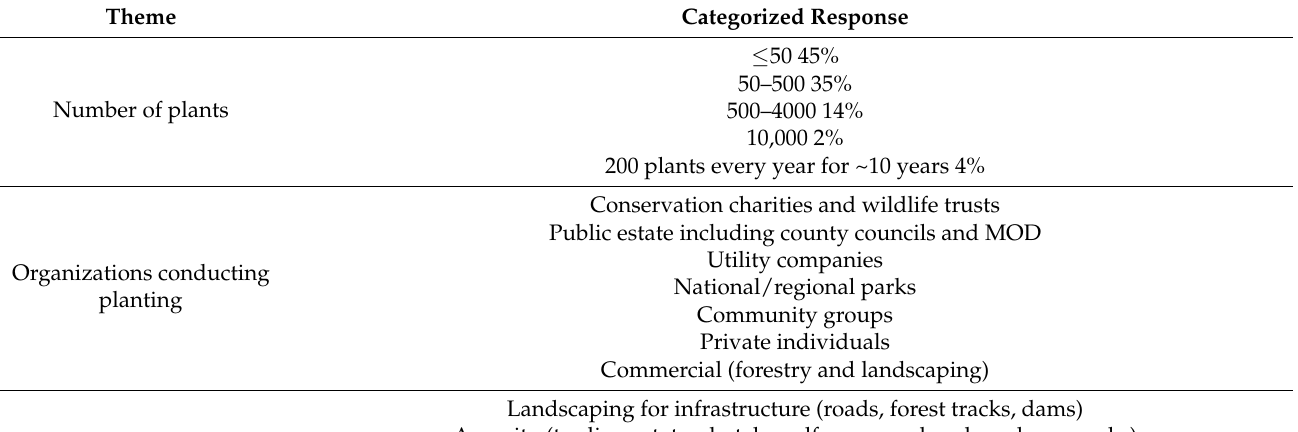
Table 1. List of responses associated with planting records that address the themes (shown in bold) exploring who carries out juniper planting in the UK, their motivations, scheme size and sources of material. Responses are listed in order of